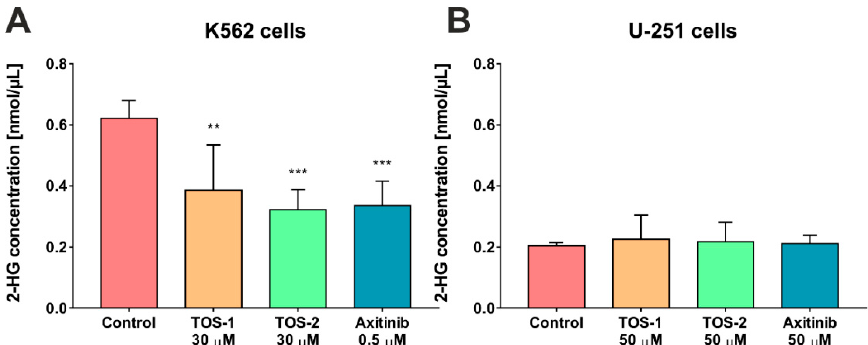
Figure 6. Influence of the tested inhibitors – TOS ‐ 1, TOS ‐ 2 and axitinib on 2 ‐ HG production in the K562 ( A ) and U ‐ 251 cells ( B ). Data were analyzed using a one ‐ way ANOVA with Bonferroni’s post ‐ hoc test: * p < 0.05, ** p < 0.01, *** p < 0.001 compared to the control (untreated cells).